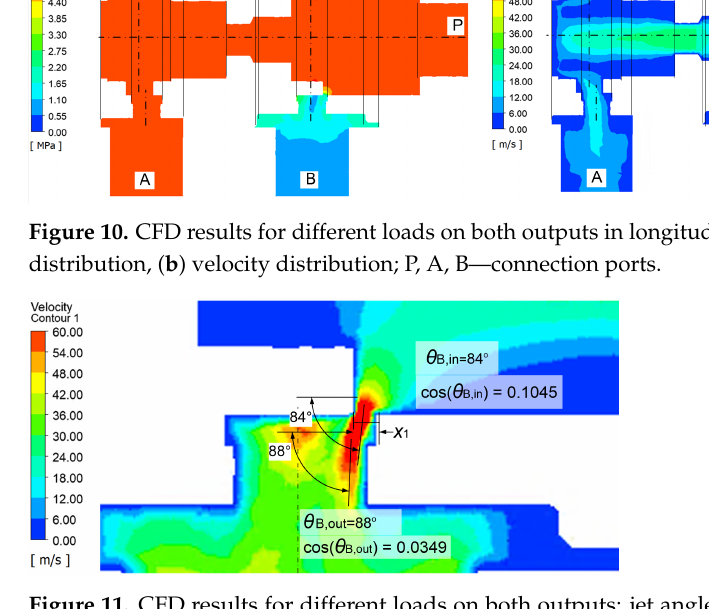
Figure 11. CFD results for different loads on both outputs: jet angle in the B gap; θ B , in , θ B , out —jet angle at inlet and outlet; P, A, B—connection ports.